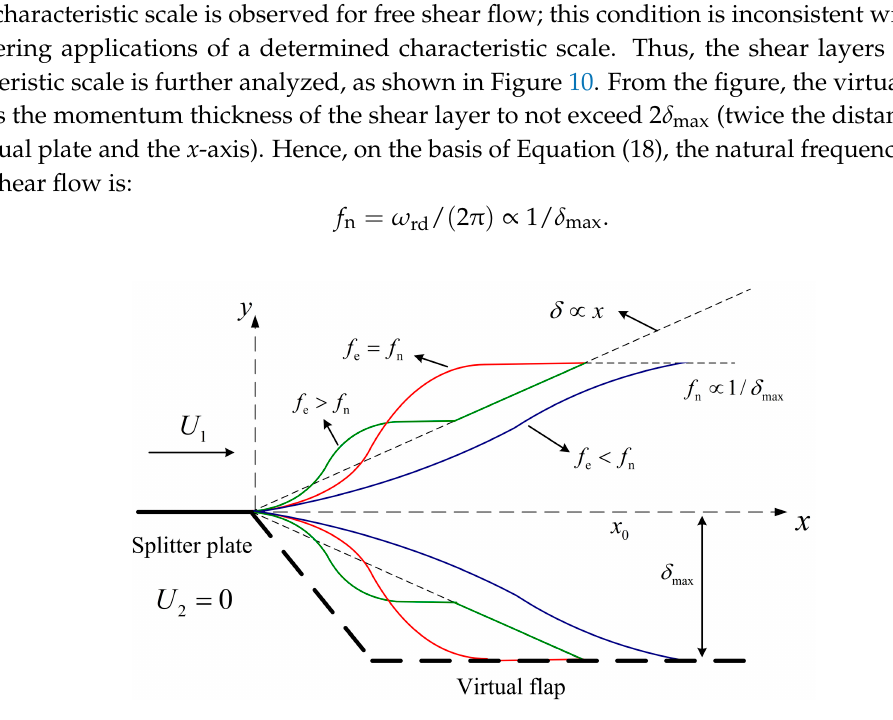
Figure 10. Momentum thickness development diagram of the shear layer with characteristic scale under typical excitation frequencies.